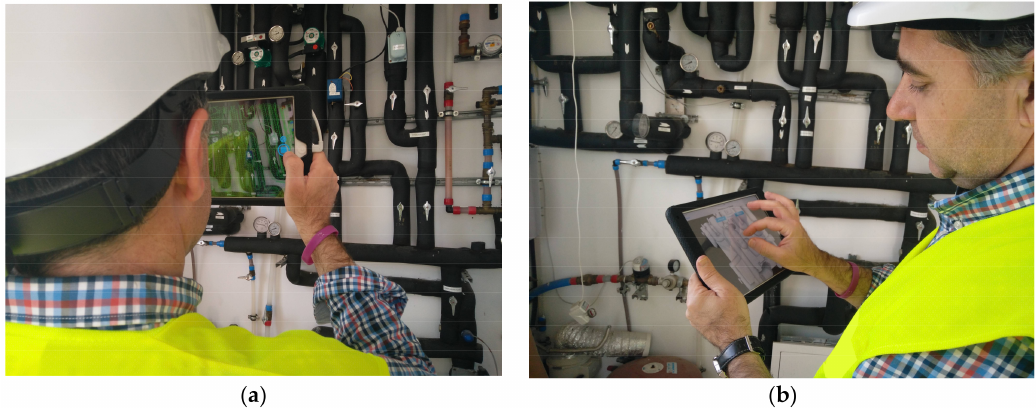
Figure 6. An inspector making use of the interactive tool in the process of acquiring 3D data of a defective piece: ( a ) acquiring the shape of the piece; and ( b ) inspecting the acquired